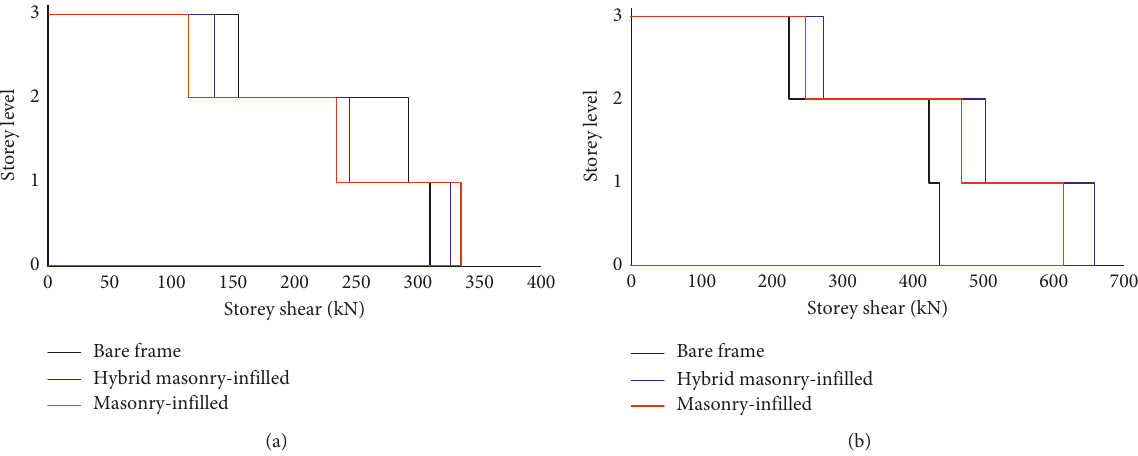
Figure 12: Maximum interstory shear envelope of test structures for increasing input excitation. Story shears were converted to the corresponding prototype values. (a) Interstory shear under NR1. (b) Interstory shear under